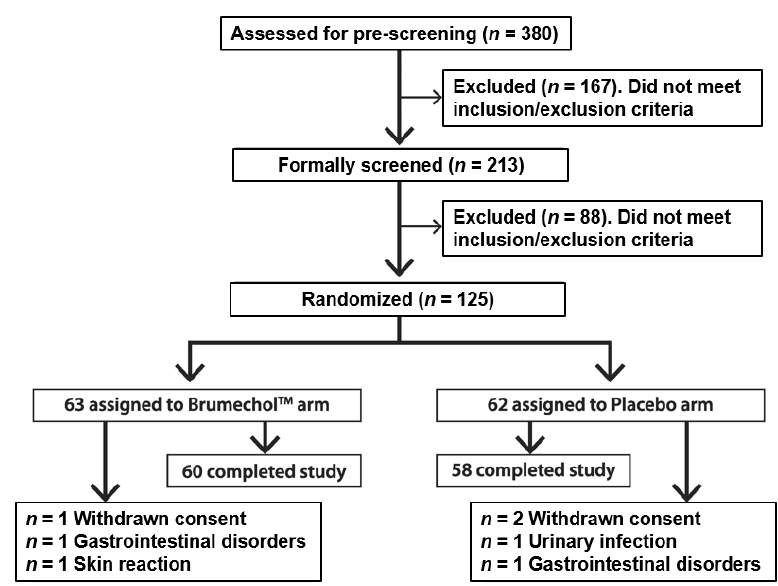
Figure 1. Flow chart of participants. Table 1. Baseline clinical and biochemical characteristics of the enrolled subjects who completed the study by treatment